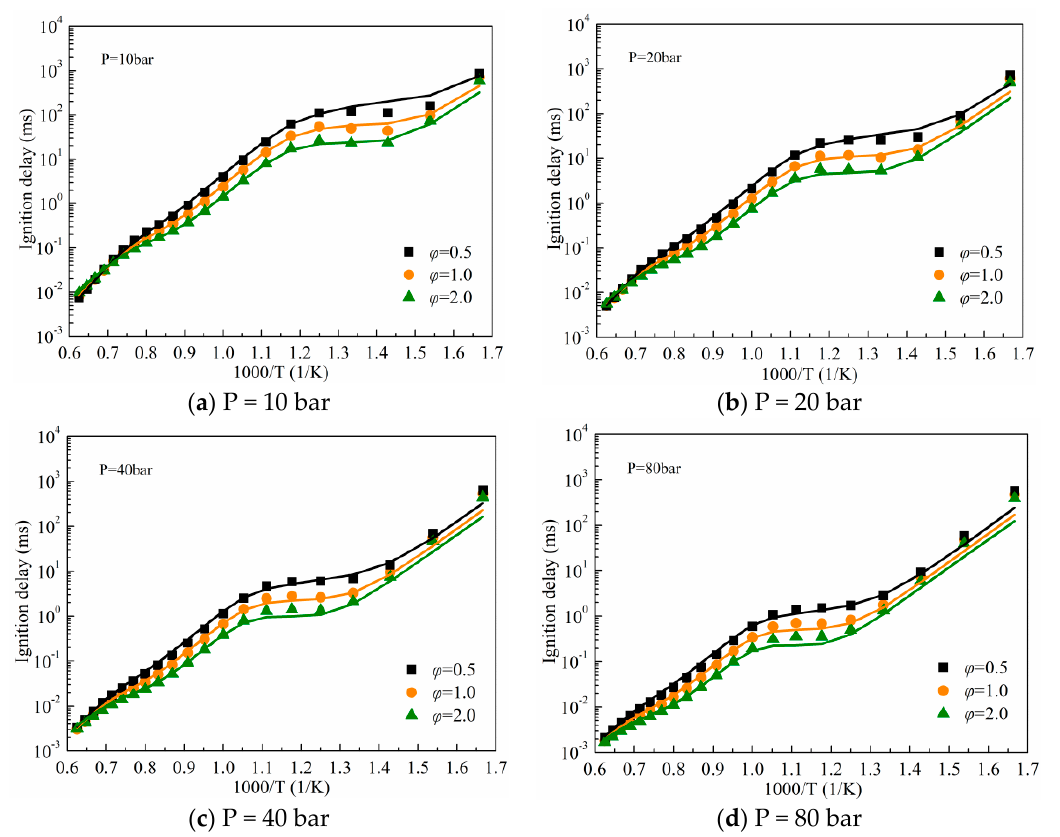
Figure 1. Predicted ignition delays of MTHF2 by detailed mechanism [17] (symbols) and reduced mechanism (lines) based on DRGEP + RPA.